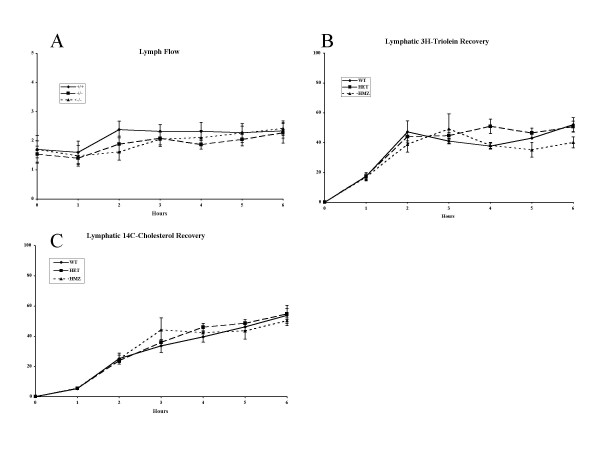
Intestinal lipid absorption in F2 rats. Male F2 rats had their lymph ducts cannulated as described (see Methods) and had lymph flow quantitiated to ensure adequate and stable flow (panel A). Labeled triolein (panel B) or cholesterol (panel C was administered via the duodenal tube, and the recovery of radio-isotope in the lymph quantitated with time. No differences in the appearance of label for either triolein (triglyceride absorption) or cholesterol was observed between WT, HET or HMZ F2 rats.